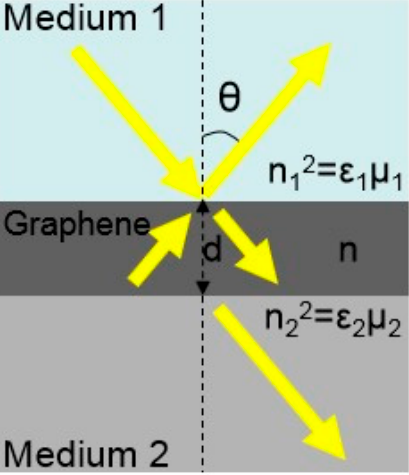
Figure 5. Schematic of a graphene layer sandwiched between two